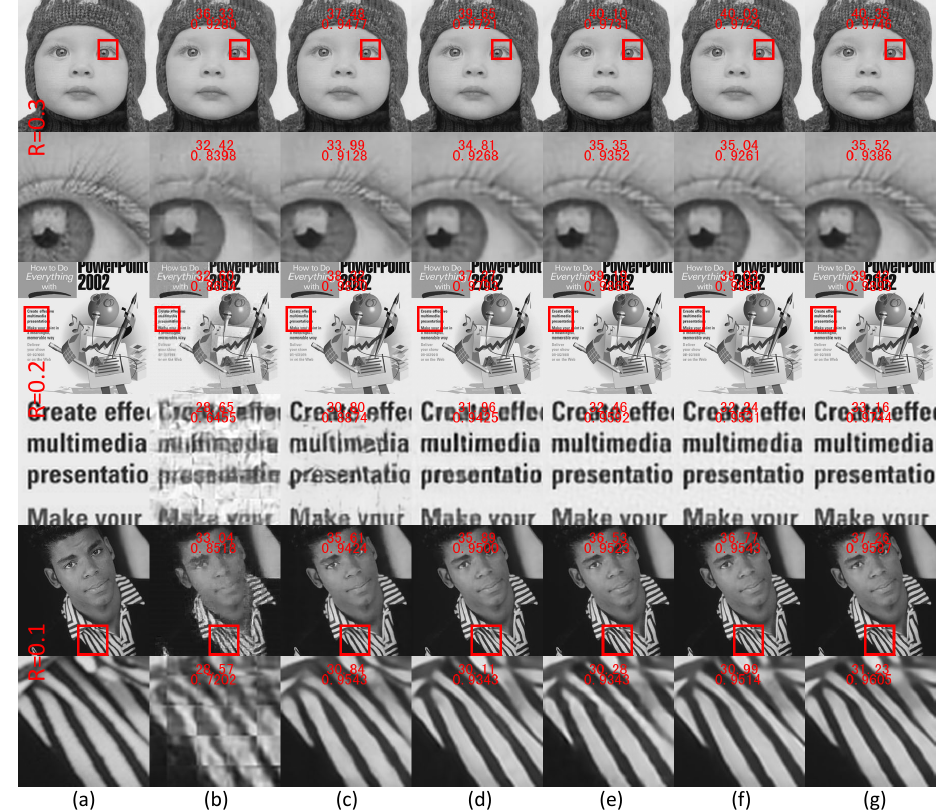
Figure 10. The results of the qualitative evaluation. ( a ) Ground truth, ( b ) ReconNet, ( c ) ISTANet++, ( d ) CSNET, ( e ) AMPNet, ( f ) EiCSNet2*1, and ( g ) EiCSNet6*1. The three ratios of 0.1, 0.2, and 0.3 and one image from each of the three datasets are selected for comparison. Parts of the whole image are marked with red boxes. The marked parts are shown in an enlarged view below the corresponding images. The indicators of the complete and enlarged images are calculated and listed.